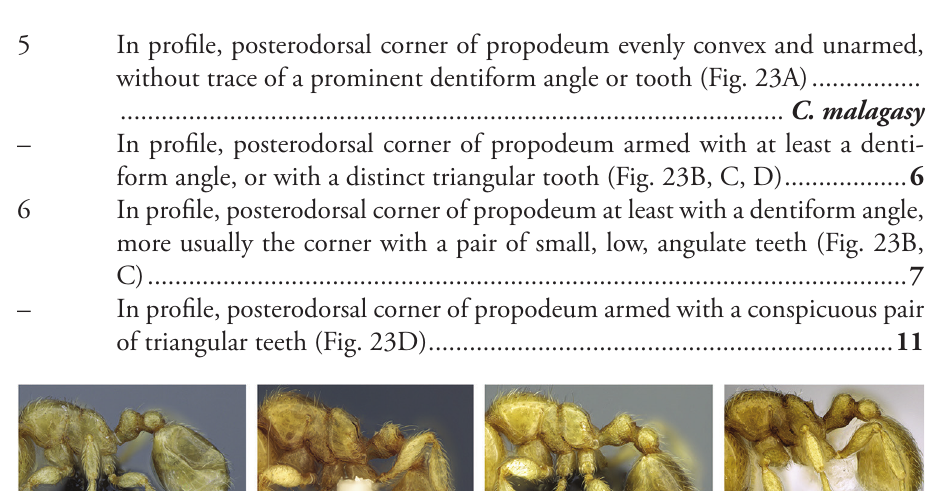
Figure 22. Mesosoma, petiole and postpetiole in profile view of A Carebara hiragasy (CASENT0496888) B Carebara placida (CASENT0070817).